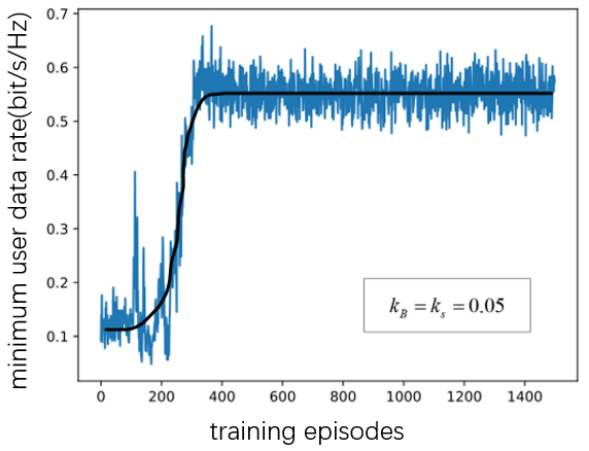
Figure 8. Convergence Speed when k B = k S = 0.05.